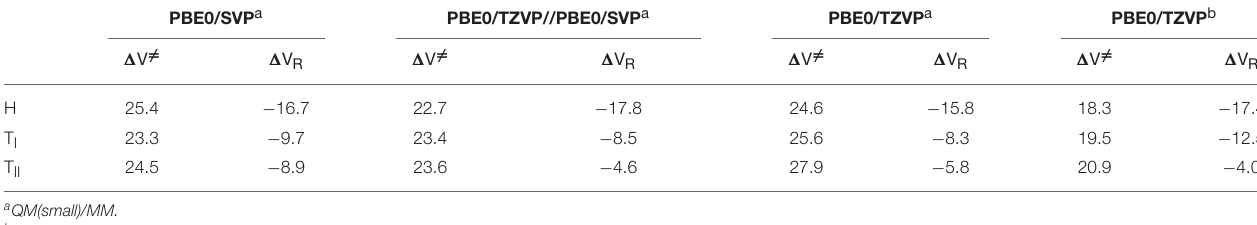
TABLE 3 | Potential energy barriers ( 1 V 6= ) for the hydrolysis (H) and transglycosylation processes (T I and T II , corresponding to the two different frames studied) along with the corresponding reaction energies ( 1 V R ) with the two QM/MM partitions and at the different QM levels employed.